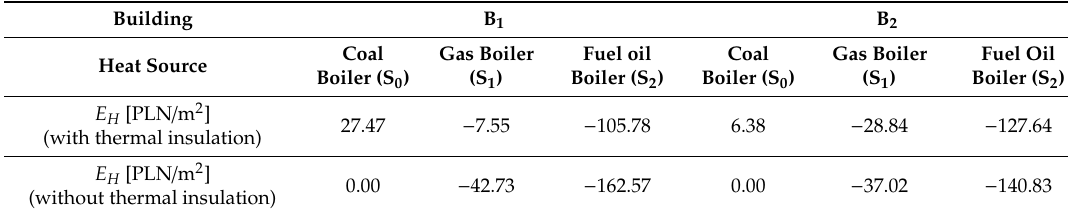
Table 11. Reduction of economical heating costs.